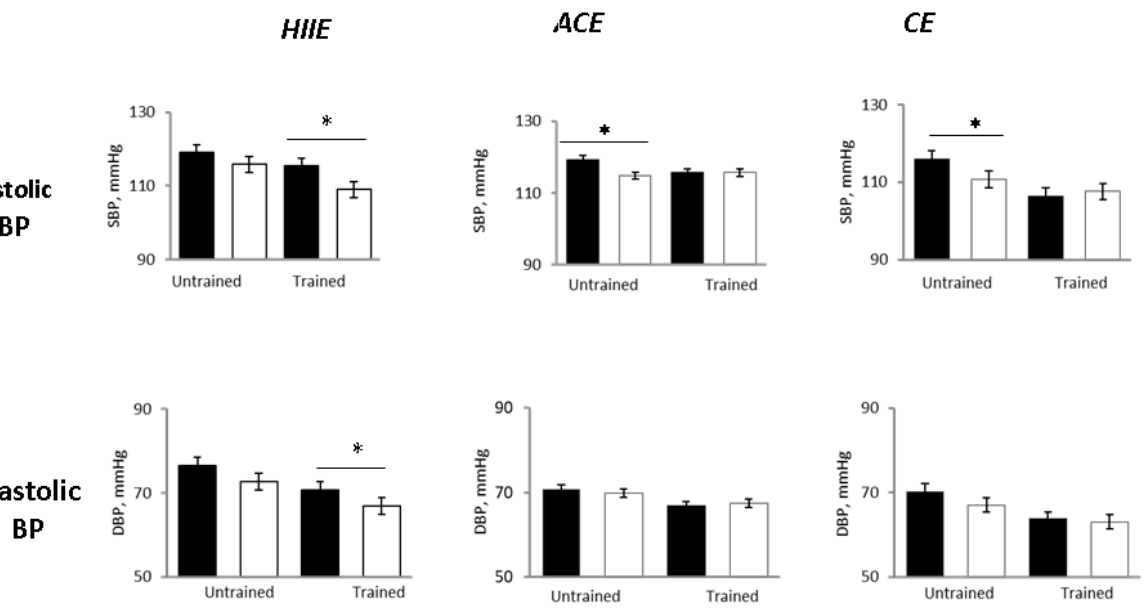
Figure 2. Post-exercise changes in ABPM 24-h systolic and diastolic blood pressure (BP) in the three study groups before (black bars) and after (white bars) a single exercise session in the untrained and trained status. HIIE, high intensity interval exercise; ACE, aerobic continuous exercise; CE, combined exercises. * p < 0.05 vs. pre exercise.